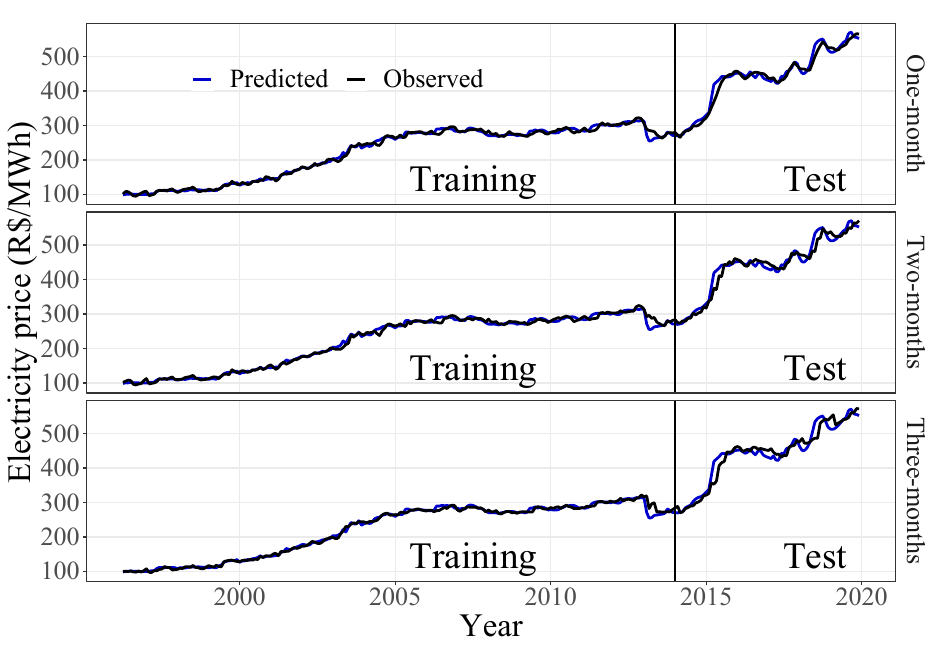
Figure 7. Variables Importance for the proposed model in each dataset.